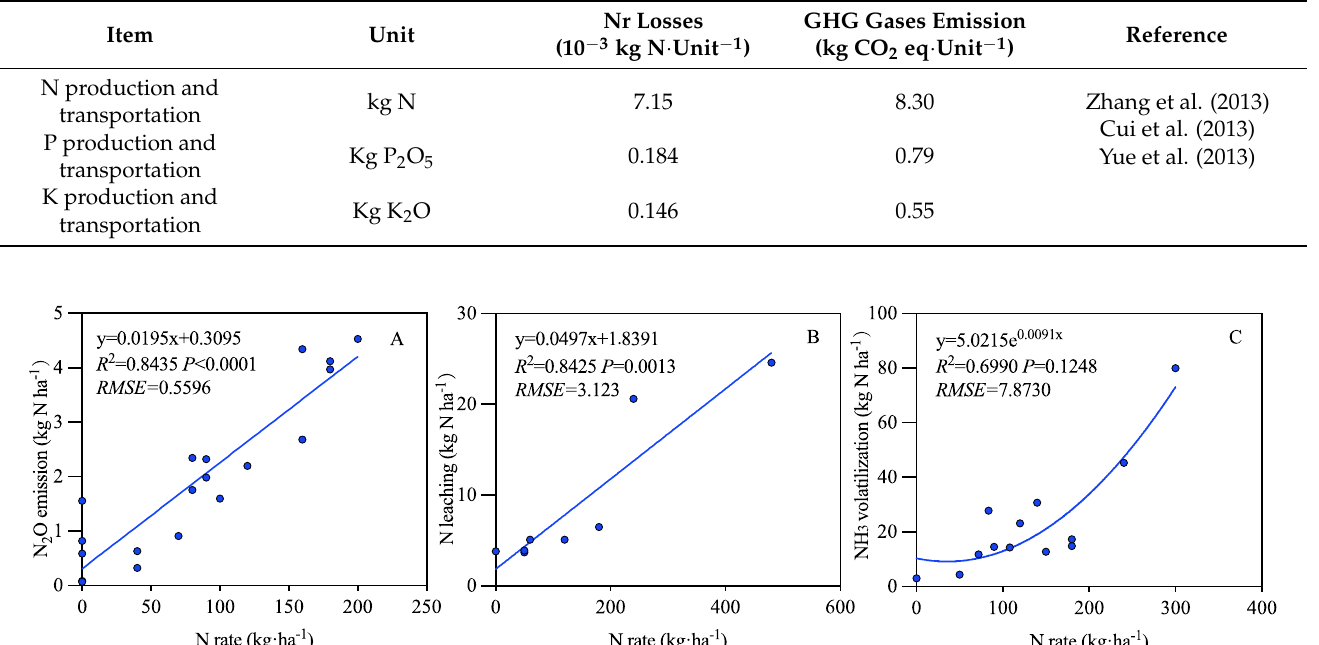
Table A1. Nr losses and GHG emission for production and transportation of various agricultural inputs in the forage sorghum production system.